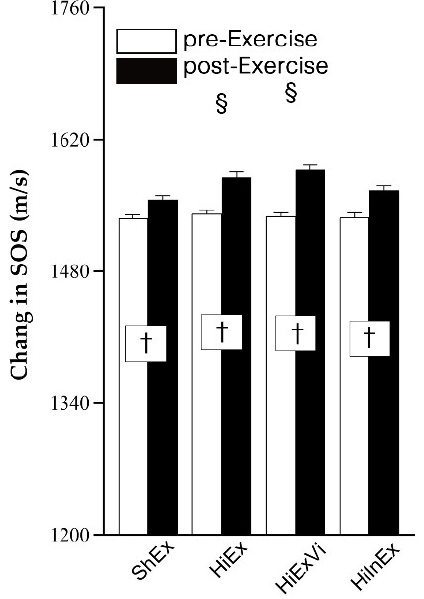
Figure 1. The change in speed of sound (SOS). ShEx—sham exercise; HiEx—high-impact exercise; HiExVi—high-impact exercise with various directions; HiInEx—high-intensity interval exercise. Data are presented as mean ± standard deviation (SD). † indicates that the difference between pre- and post-exercise is significant ( p < 0.05). § denotes that the difference in change magnitude is significant in HiEx, HiExVi, and HiInEx groups compared with ShEx group ( p < 0.05).